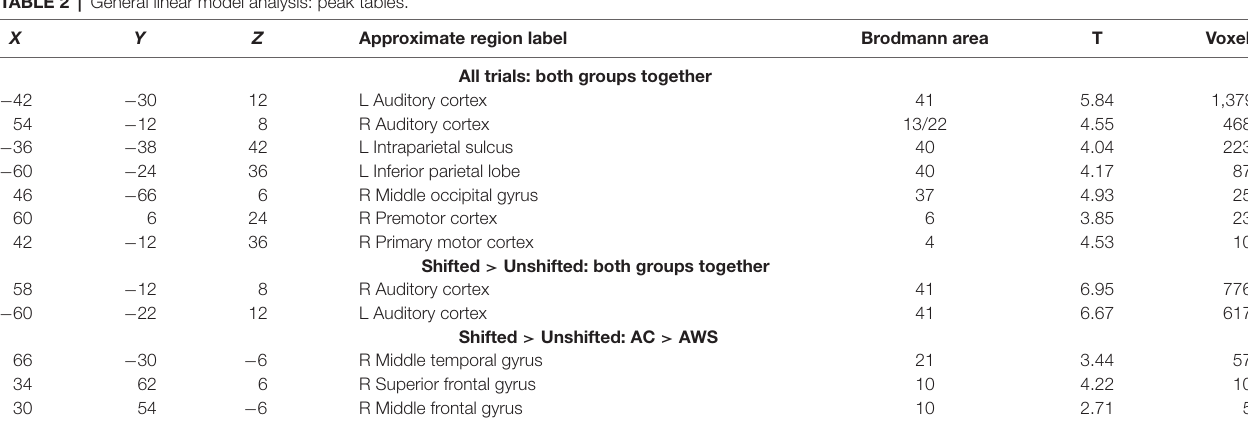
TABLE 2 | General linear model analysis: peak